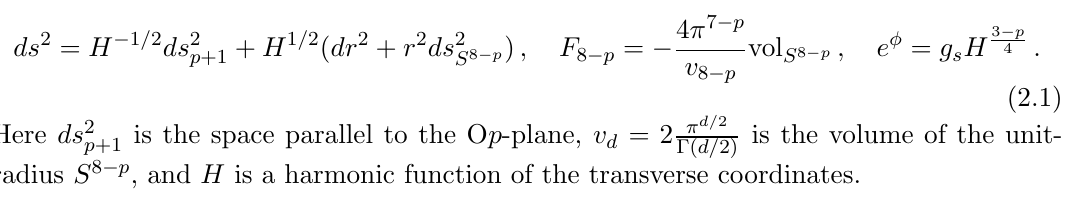
Figure 1 . The function H for O p -planes with p < 7 becomes negative at some value r = r radial coordinate. For 3 < p < 7, curvature and string coupling become strong already for larger values of r , in a region schematically shown in red